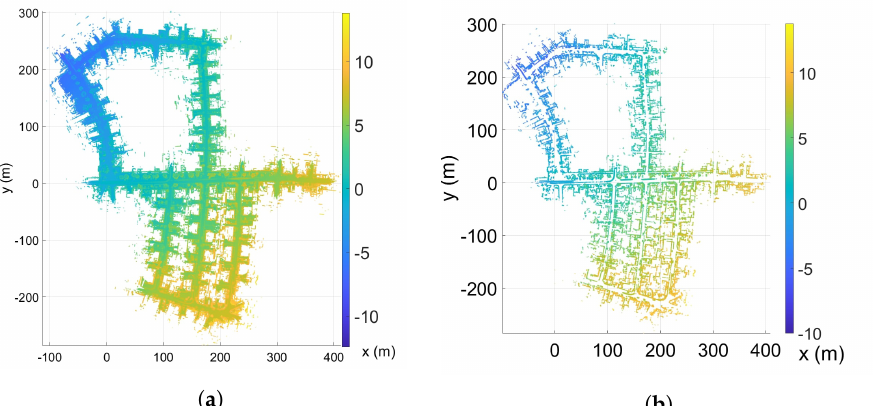
Figure 3. A sample map from the KITTI odometry dataset (sequence 5). ( a ) Top view, ( b ) Top view (road